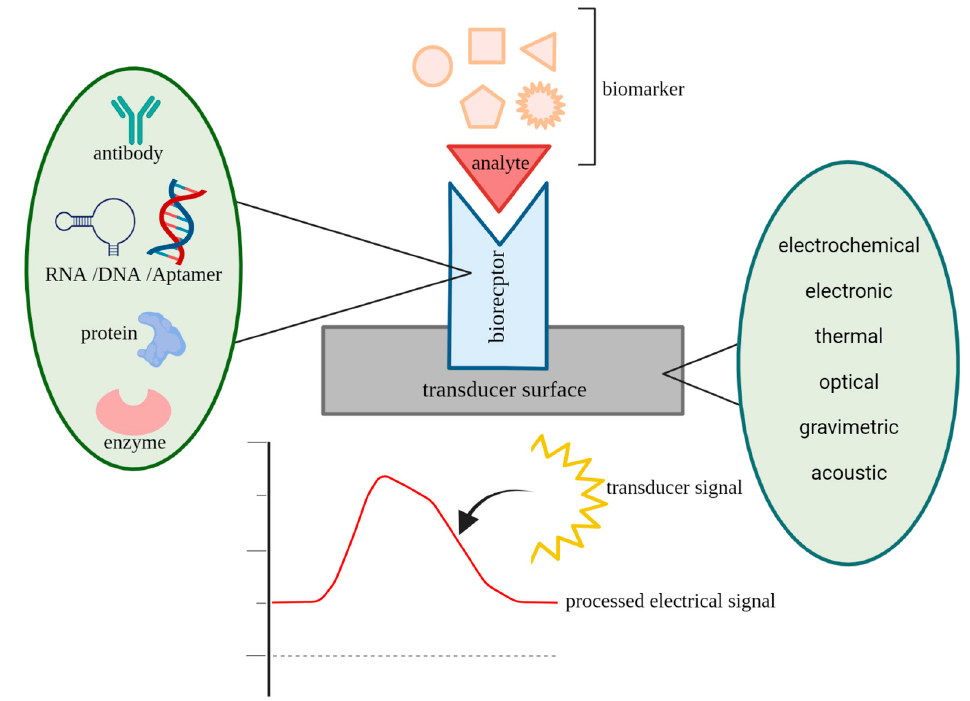
Figure 1. Schematic picture of a biosensor’s construction and function.